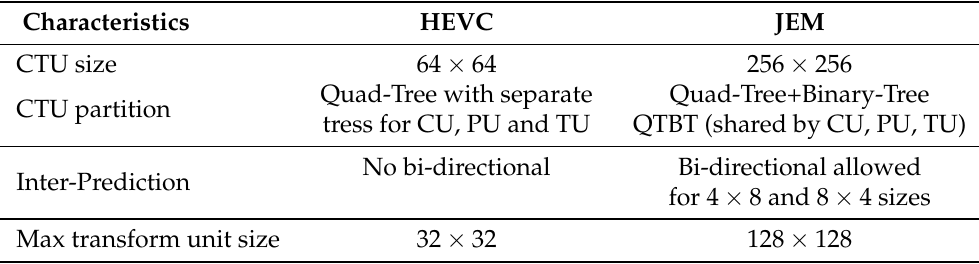
Table 1. Differences between HEVC and JEM with respect to picture